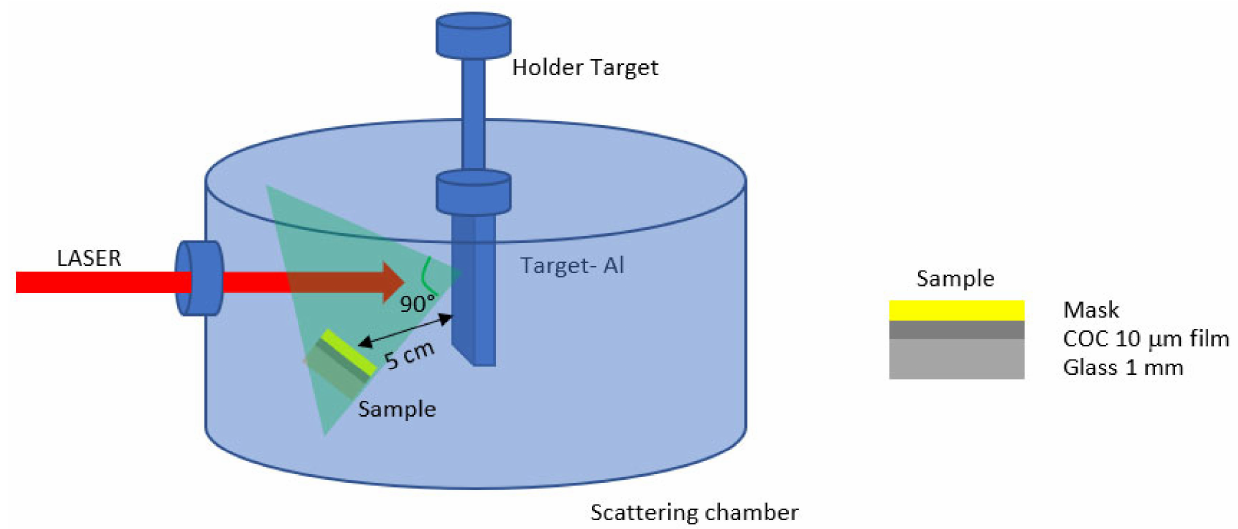
Figure 2. Schematic illustration of the pulsed laser deposition